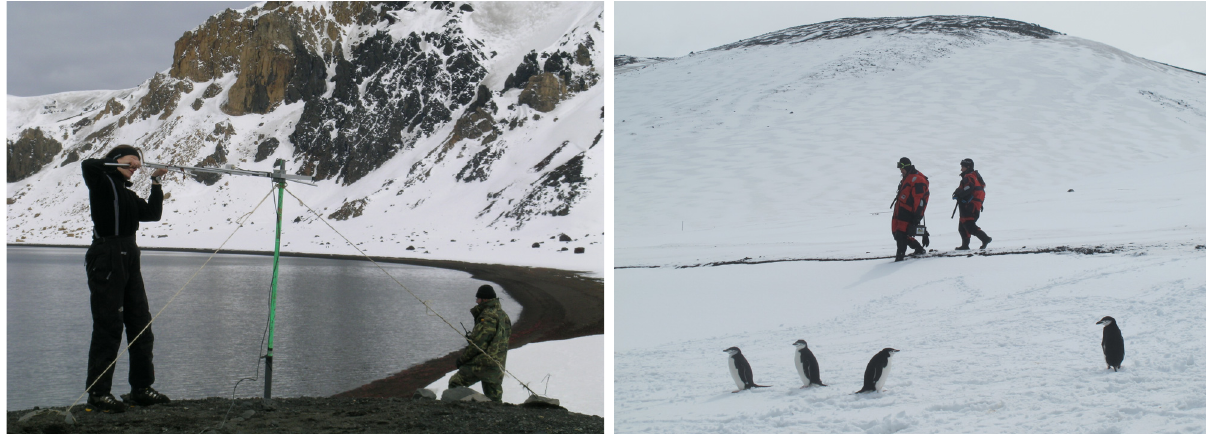
Figure 3. Maintenance operations of a seismic network station during the 2003-2004 survey. Left: inspection of the radio telemetry antenna; right: battery